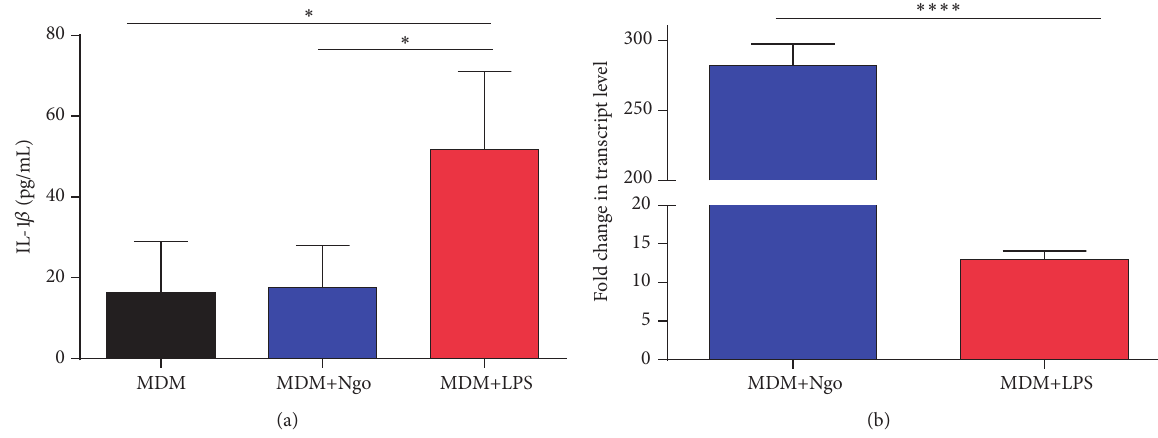
Figure 1: Ngo inhibits IL-1 𝛽 levels in culture supernatants from infected MDM but is not able to inhibit IL-1 𝛽 mRNA expression. MDM cells were infected with Ngo and then cytokine and RNA levels were evaluated after 30 minutes after infection. (a) Detection of IL-1 𝛽 in culture supernatant by ELISA. (b) Transcriptional cytokine analysis by qRT-PCR. Results represent fold changes in transcript levels between no infected MDM and MDM infected with Ngo or treated with LPS. Data obtained are expressed as the mean ± SD and represent at least 6 independent experiments. ∗ 𝑃 < 0.05 ; ∗∗∗∗ 𝑃 < 0.0001 .